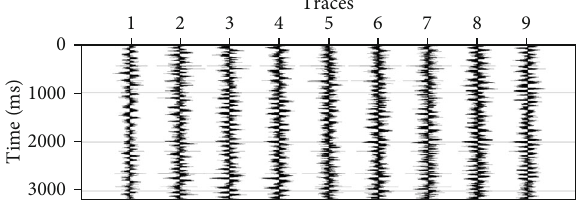
Figure 20: Actual low-SNR microseismic record pro fi le of a working area in Sichuan